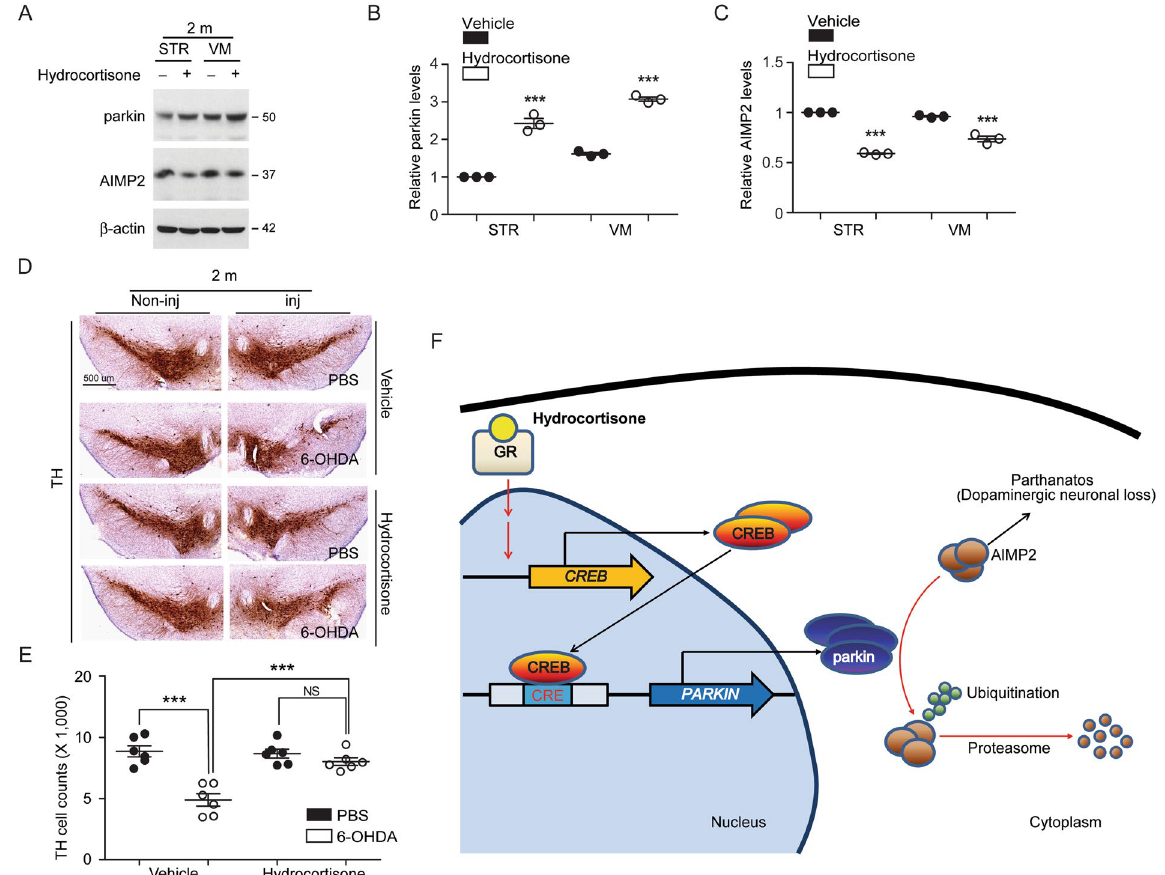
Figure 6. Hydrocortisone prevents dopamine cell loss in 6-OHDA mouse model. ( A , B , C ) Western blot analysis of parkin and its substrate AIMP2 in the striatum and ventral midbrain regions of mice (2 months old) treated with hydrocortisone or DMSO for 7 days. Relative parkin or AIMP2 protein levels were normalized to that of β -actin and shown as plot graphs ( n = 3 mice per group). ( D ) Representative tyrosine hydroxylase (TH) immunohistochemistry (scale bar = 500 um) of the substantia nigra of 6-OHDA PD mouse models treated with hydrocortisone or DMSO. 6-OHDA (8 µ g) was stereotaxically injected into the striatum (coordinate from bregma, L: − 2.0, AP: 0.5, DV: − 3.0 mm) to model dopaminergic neurodegeneration in mice. ( E ) Stereological assessment of tyrosine hydroxylase (TH)-positive dopaminergic neurons in the substantia nigra pars compacta of injection side from the indicated mouse groups ( n = 6 mice per group). ( F ) Schematic summary of proposed molecular pathways illustrating hydrocortisone-mediated induction of parkin expression. Hydrocortisone binds to glucocorticoid receptor which in turn leads to expression of CREB. CREB increases parkin expression via binding to CREB binding motifs of parkin promoter region. Hydrocortisone-stimulated parkin expression results in the downregulation of the toxic parkin substrate AIMP2, which is beneficial for dopaminergic neuronal survival. Quantified data are expressed as mean ± s.e.m. *** P < 0.001, unpaired two-tailed Student’s t test ( B , C ) and ANOVA test followed by Tukey post hoc analysis ( E ). Full blots (for cropped images in A ) are presented in Figure